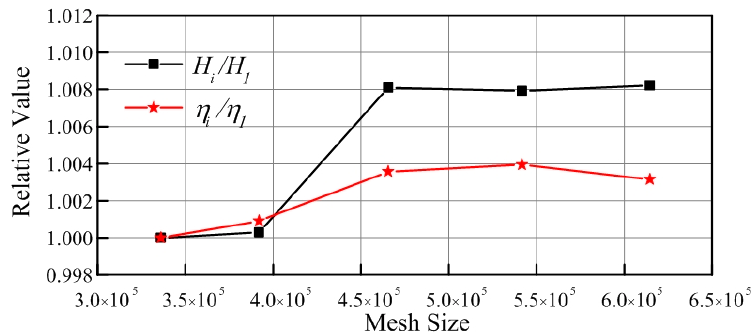
Figure 4. Mesh independence test.